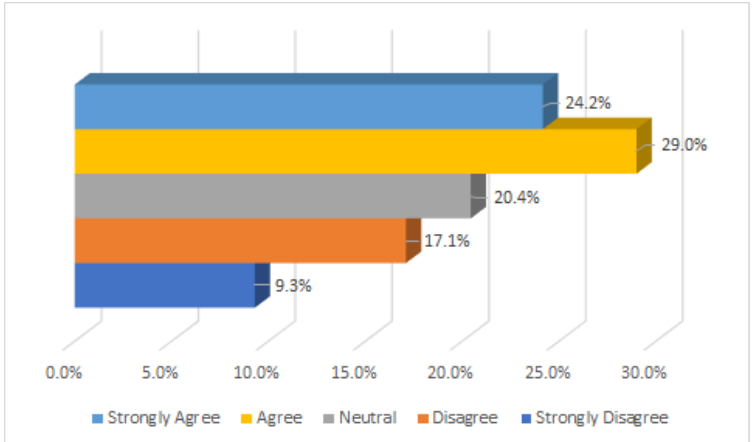
Figure 10. Answers to a Likert five-point scale to the question: Do you think the tests employed have helped generating a positive-emotion environment?